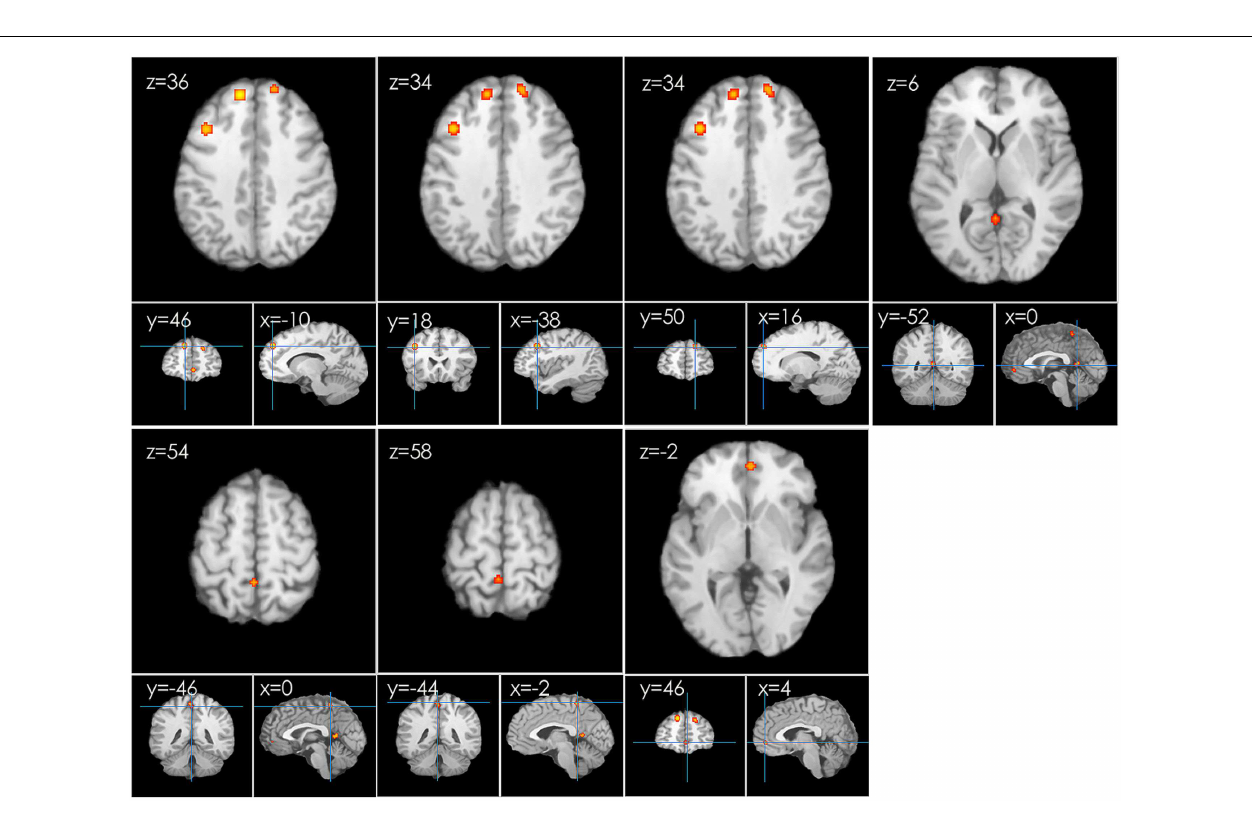
FIGURE 3 |AnALE map presenting the increased activity in postmenopausal women undergoing HT during working memory tasks compared with the controls ( p < 0.01; FDR-corrected; k > 100)